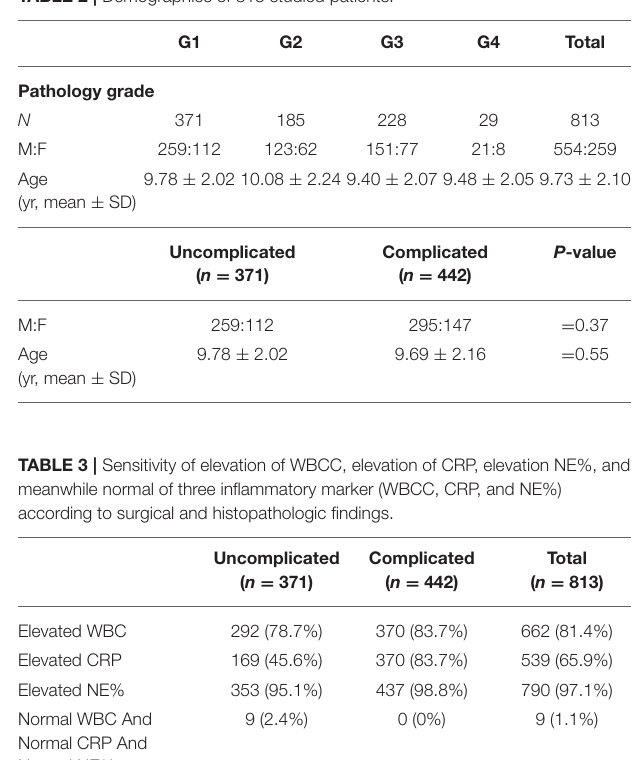
TABLE 4 | Analysis of type of appendicitis and elapsed